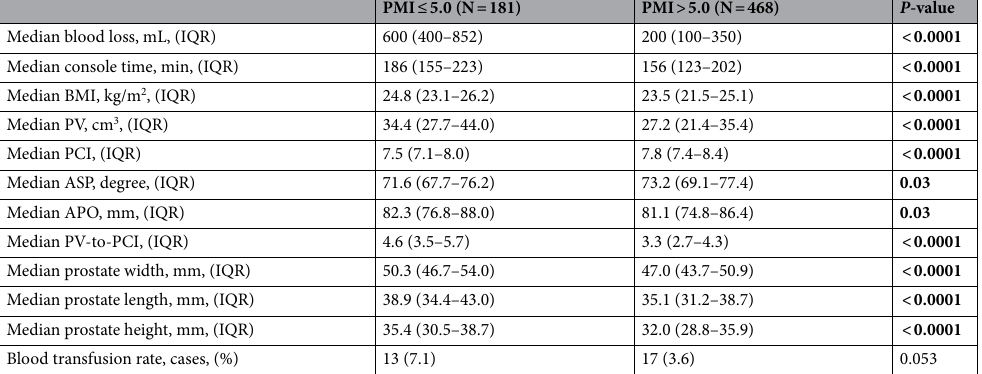
Table 1. The relationship between PMI and other parameters (N = 649). PMI > 5.0 mm was defined as ‘high PMI’. Statistical analyses were performed by the Wilcoxon rank-sum test and the chi-square test. PMI